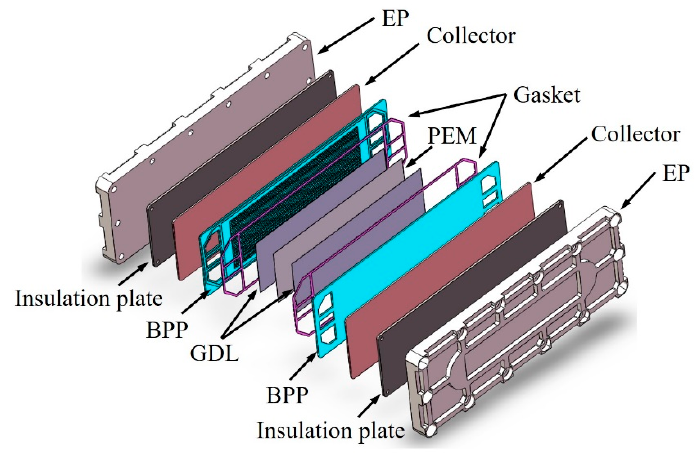
Figure 4. Full-size model of a proton exchange membrane fuel cell (PEMFC).